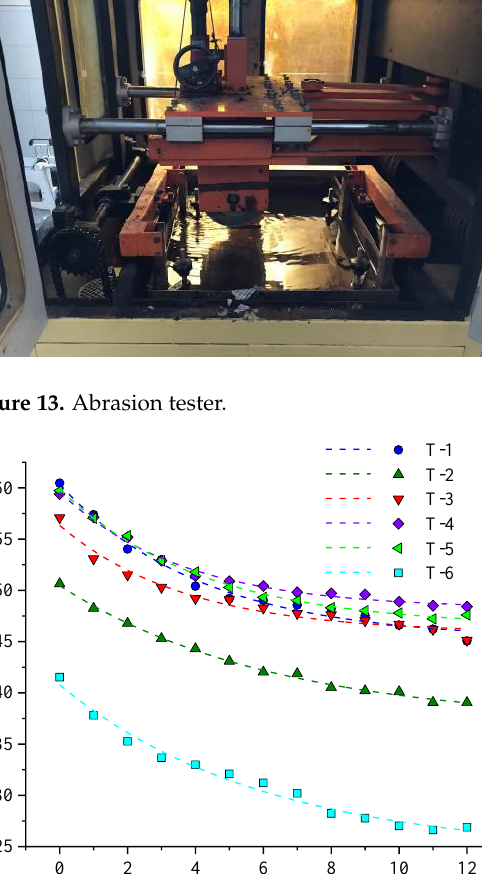
Table 11. Attenuation parameter of stationary steering resistance torque.